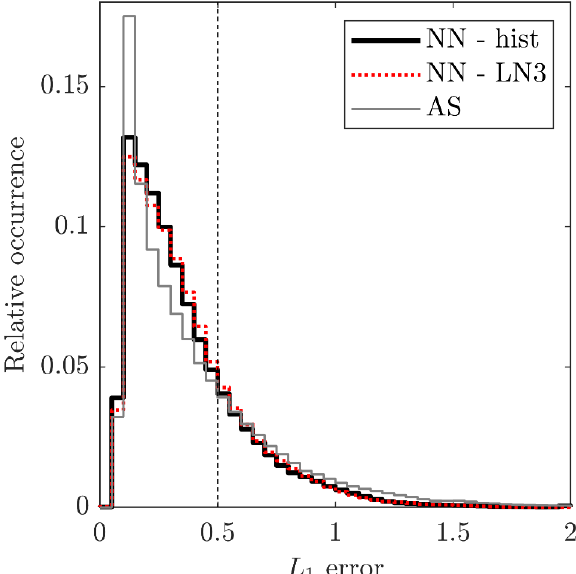
Figure 9. Distributions of testing errors for the final histogram NN (solid black line), the LN3 NN (dotted red line), and AS (thin gray line) on testing dataset 2. A greater proportion of the Area Statistics (AS) method L 1 errors are greater than 0.5 (vertical dashed line) than the NN methods.